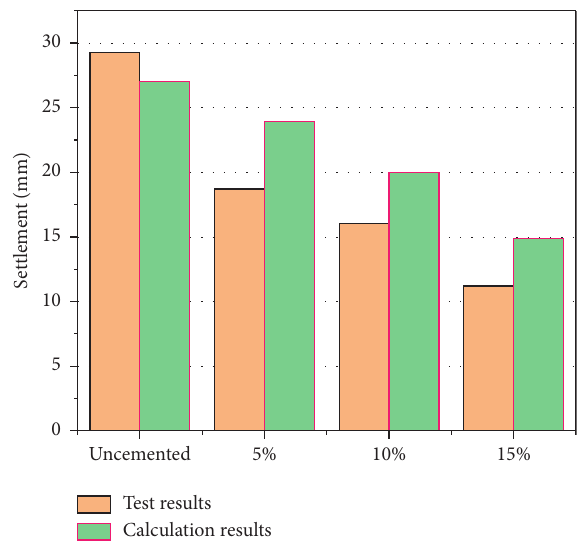
Figure 17: Comparison of settlement in calculation results and test results ( P � 400